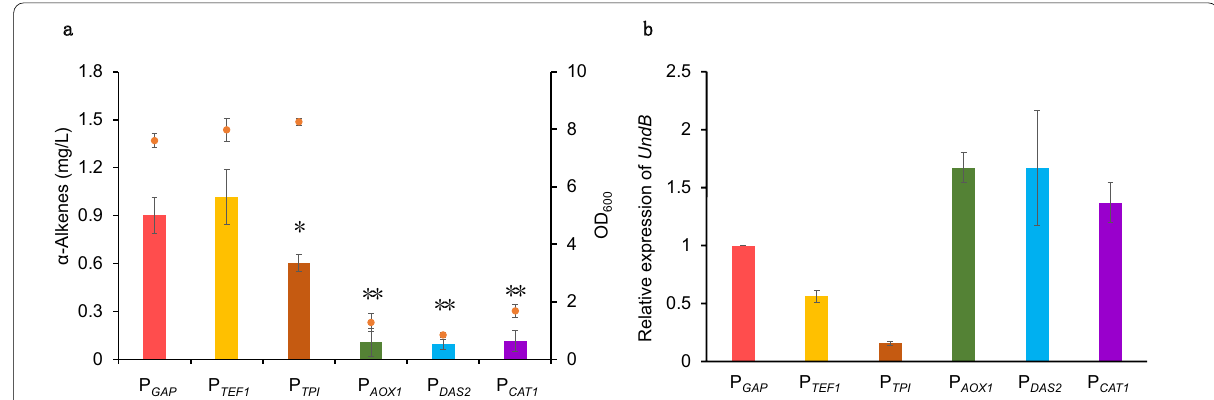
Fig. 3 Fermentation of α-alkenes from methanol as sole carbon resource. a Total α-alkenes production in corresponding strains in shake flask after 120 h cultivation in 20 g/L methanol medium. b The relative expression levels of UndB under different promoters. The housekeeping gene actin was chosen as baseline for quantification of expression level. Relative expression levels of UndB were calculated by normalized the expression level under P GAP . All data were represented as the mean s.d. of three samples. Statistical significance of the different α-alkenes levels in comparison with ± the control (P GAP ) was evaluated using Student’s t test (* P < 0.05; ** P < 0.01)